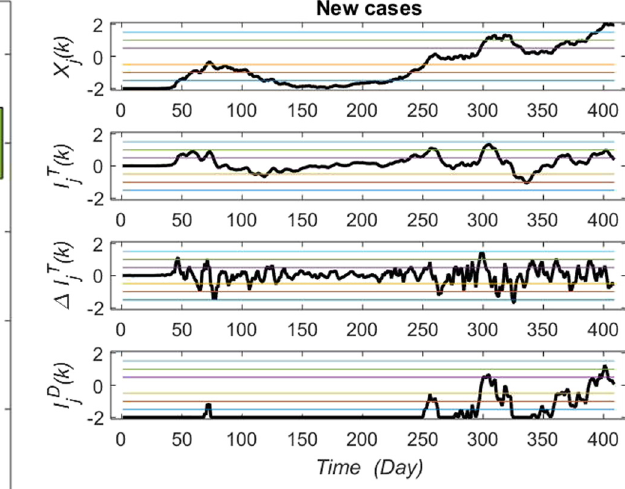
Figure 7: Temporal analysis for the new con fi rmed cases in Finland.